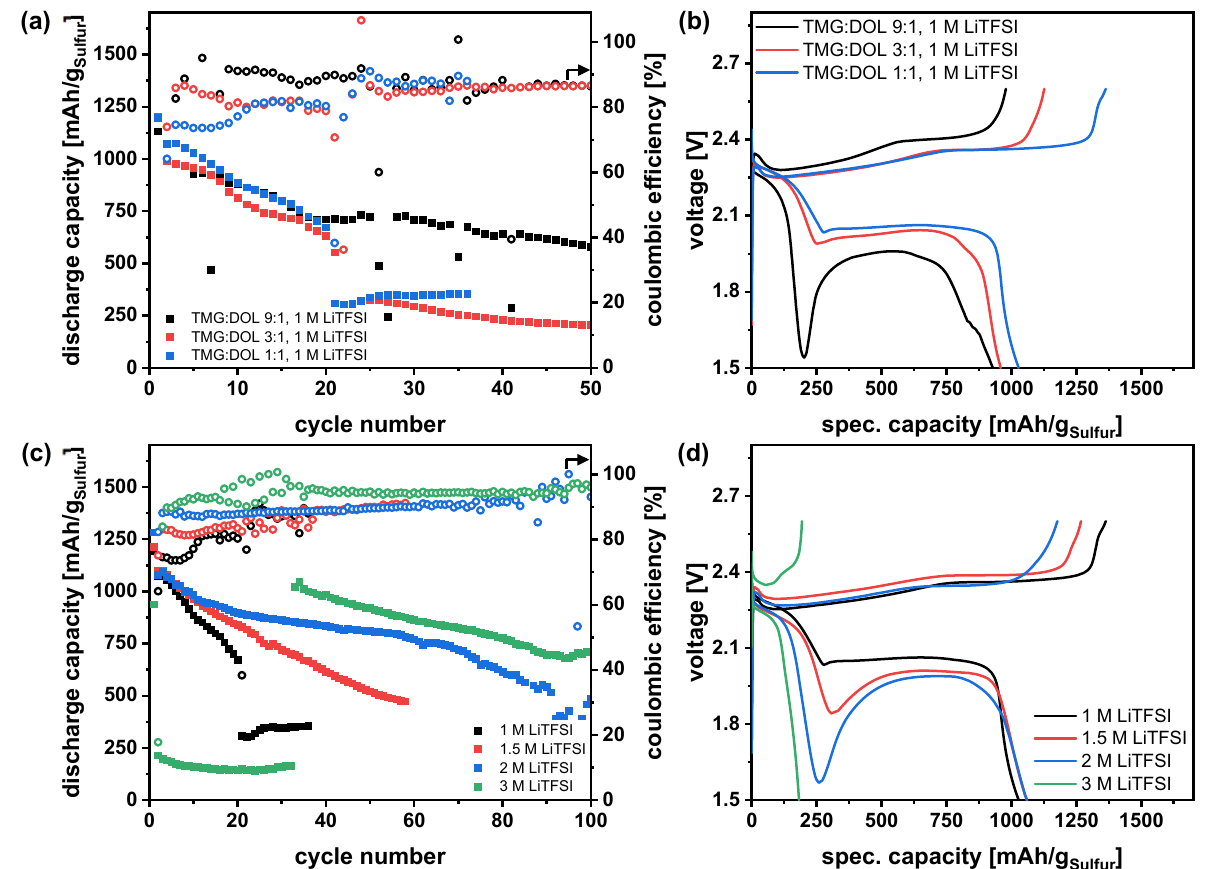
Figure 3. Galvanostatic cycling at 0.1 C and 25 °C with adjusted electrolyte compositions: influence of solvent ratio for TMG:DOL-electrolytes with 1 M LiTFSI: ( a ) cycle life, ( b ) voltage profiles of 5th cycle; influence of LiTFSI concentration for TMG:DOL 1:1: ( c ) cycle life, ( d ) voltage profiles of 5th cycle tested in coin cells.